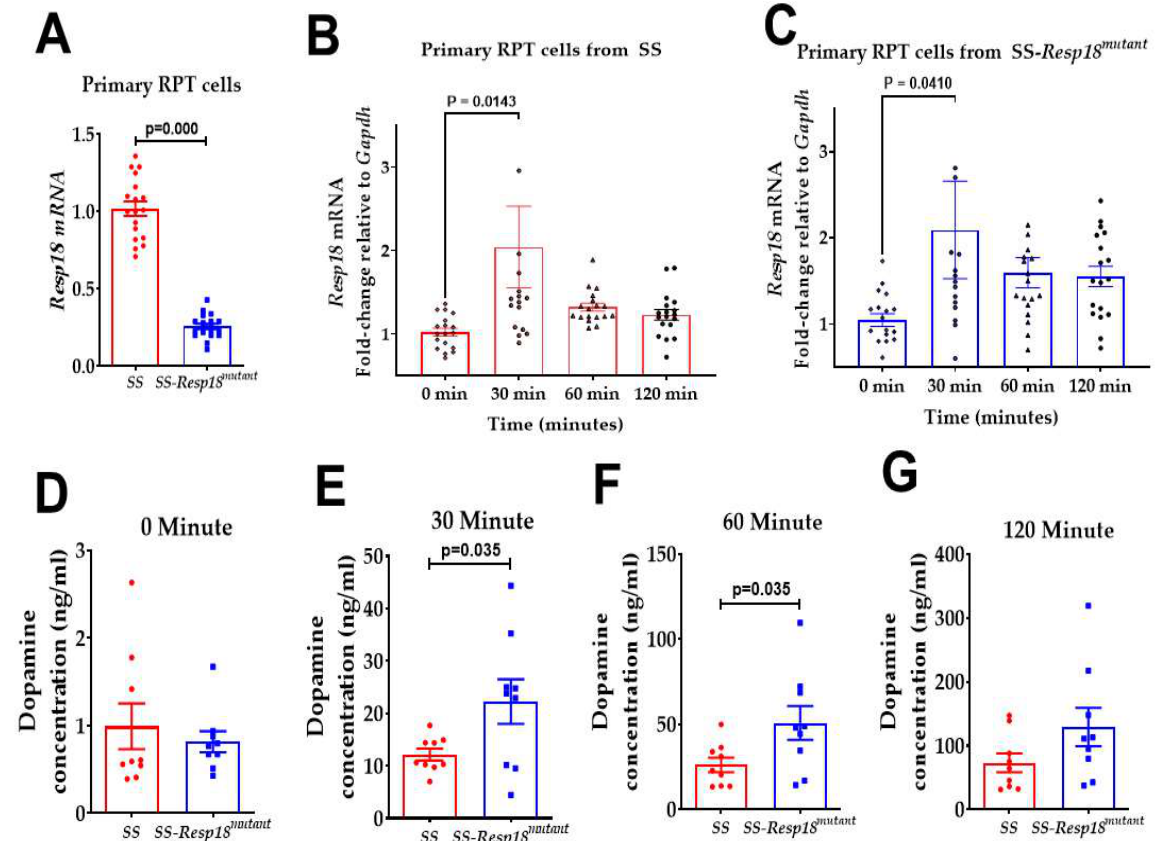
Figure 7. Renal proximal tubule (RPT) cells isolated from the SS- Resp18 mutant rats have increased dopamine production: ( A ) Resp18 mRNA expression levels in RPT cells from SS and SS- Resp18 mutant rats ( n = 4). ( B , C ) Resp18 mRNA expression levels were measured in RPT cells treated with L-DOPA (75 μM) in the presence of the monoamine oxidase inhibitor pargyline (10 μM) and the catechol-O-methyltransferase inhibitor tolcapone (1 μM). (B ) SS rats and ( C ) SS- Resp18 mutant rats ( n = 8–9). Dopamine levels were measured in RPT cells from SS and SS- Resp18 mutant rats before ( D ) and after the L-DOPA treatment ( E ) 30 min ( n = 9), ( F ) 60 min ( n = 9), and ( G ) 120 min ( n = 9). Data are mean ± SEM. p = 0.0143, p = 0.0410, vs. 0 min, two-way ANOVA (Sidak test) and p = 0.000, p = 0.035, vs. SS- Resp18 mutant t -test.